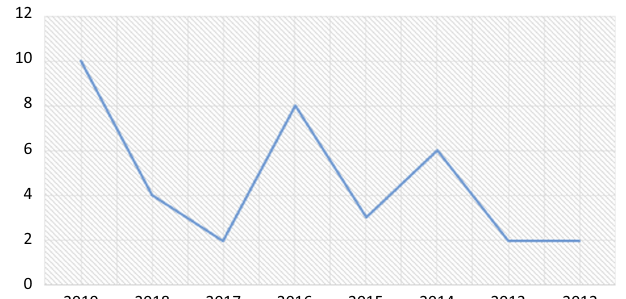
Figure 2. Range of journal